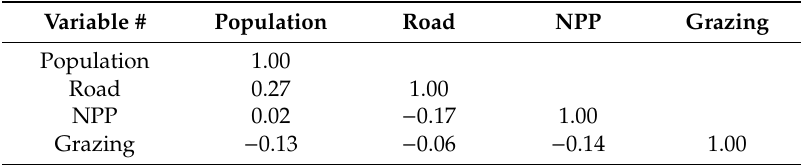
Table 1. Correlation matrix between the explanatory